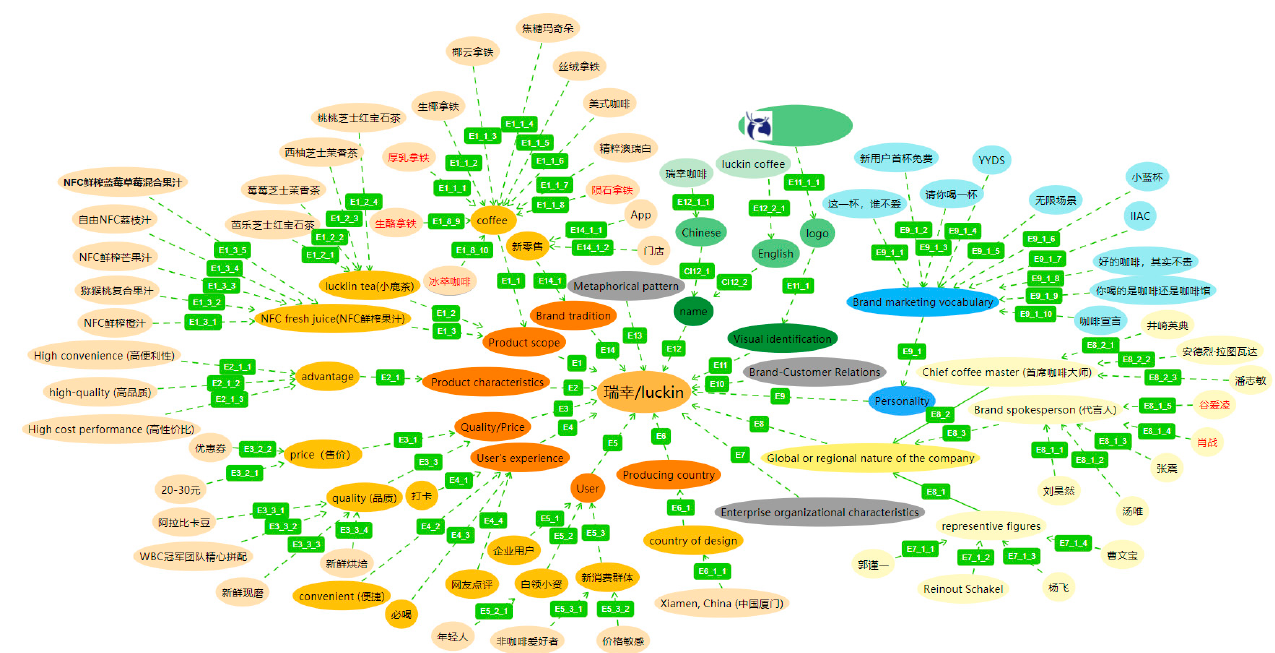
Figure 9. the BI KG of Luckin Co ff ee on 30 November 2022. Figure 9. The BI KG of Luckin Coffee on 30 November